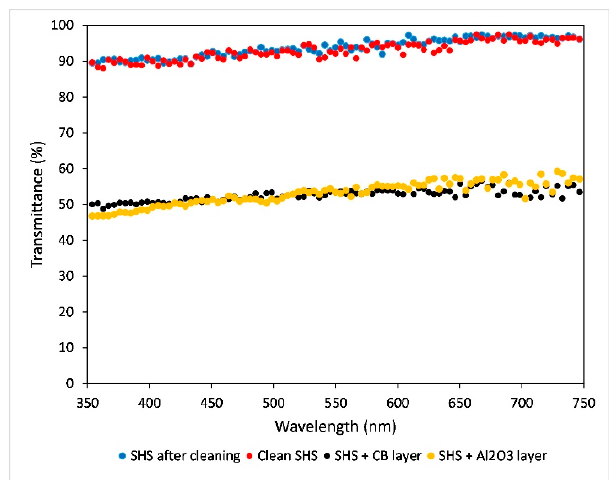
Figure 10. Transmittance spectra of same coating of Figure 9: clean (red dots), dirtied with CB and Al 2 O 3 (black and yellow dots) and coating after cleaning (blue dots). Al 2 O 3 (black and yellow dots) and coating after cleaning (blue